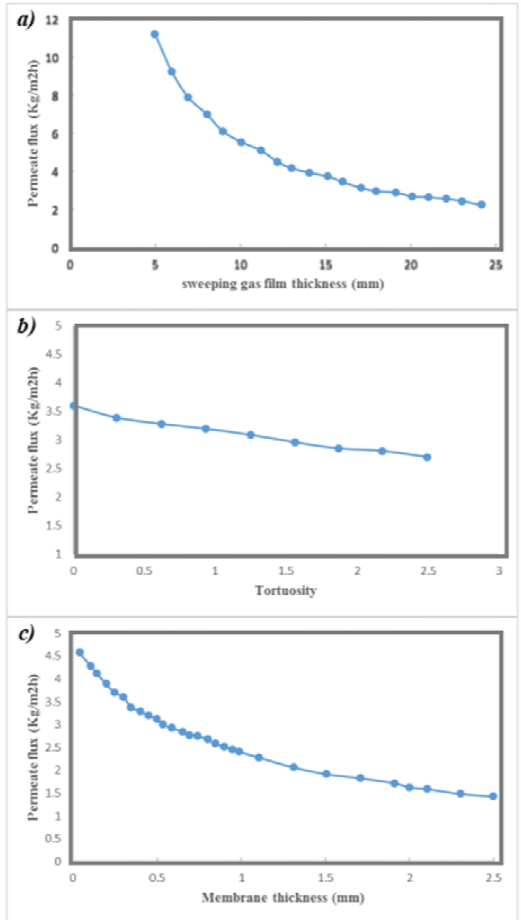
Fig. 2: Effect of a) distillate channel depth (i.e. in the cold side of SGMD) width of sweeping gas band, b) tortuosity, c) membrane thickness on permeate flux.